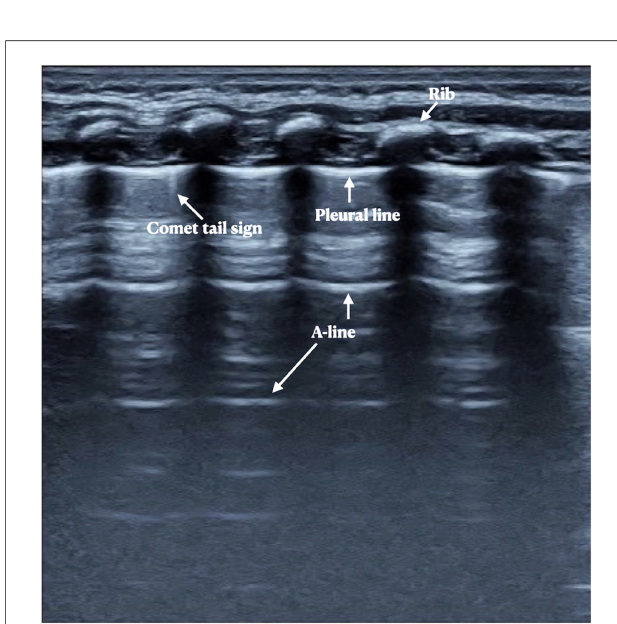
FIGURE 2 Neonatal normal lung ultrasound fi ndings. On B-mode imaging, the neonatal normal lung presents as the bamboo sign. The pleural line and A-line present as smooth, regular and hyperechoic lines arranged in parallel and equidistant from each other, and the A-line echoes gradually diminish until disappeared. In those infdants less than a week after birth, a few B-lines or comet tail signs may sometimes be seen, but there is no pleural effusion or lung